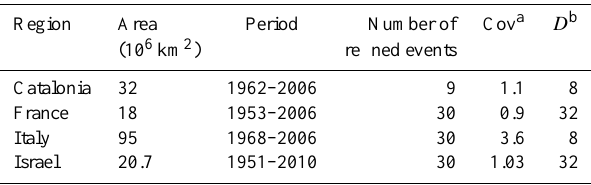
Table 1. Number of flash flood events listed in the database for each